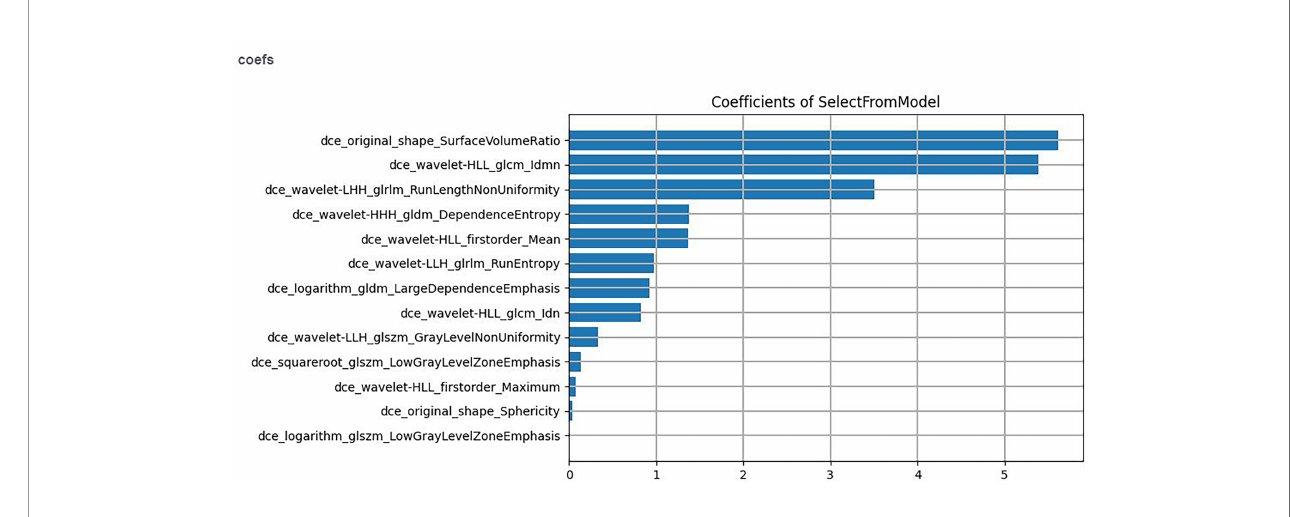
FIGURE 2 | The fi nal selected